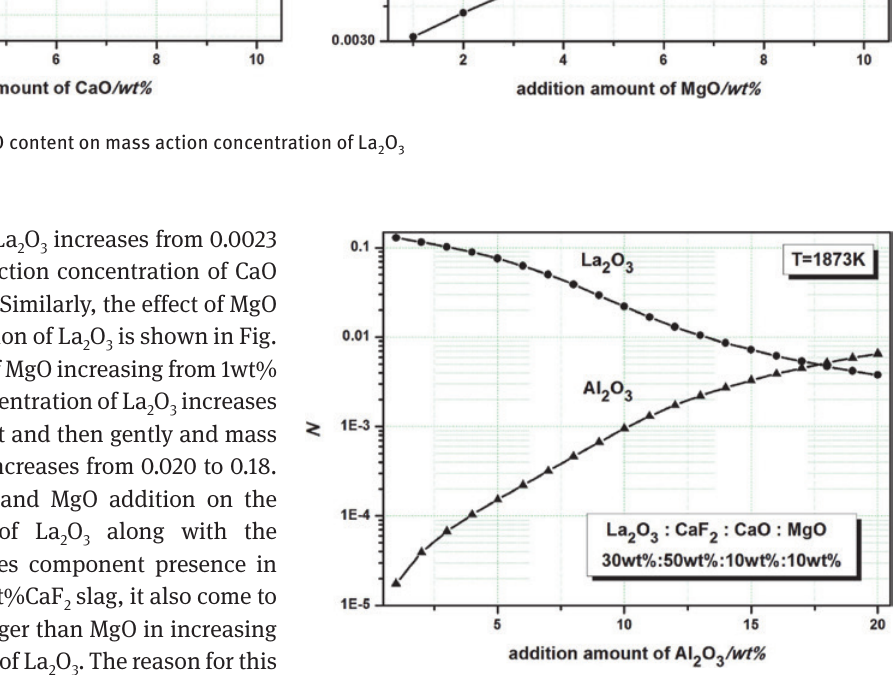
Fig. 6: The influence of Al 2 O 3 content on mass action concentration of La 2 O 3